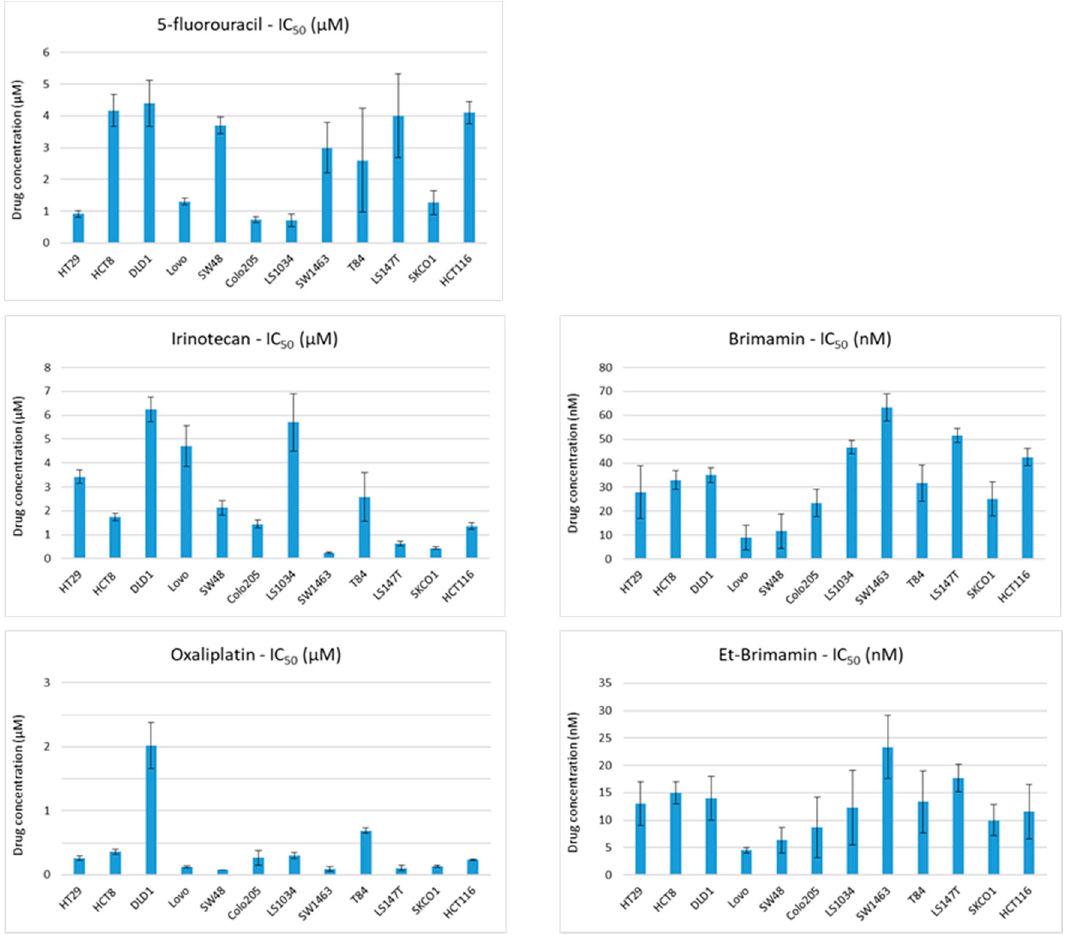
Figure 2. Cytotoxic activities of brimamin and Et-brimamin compared with those of conventional drugs in CRC cell lines. Displayed are the means of IC 50 values ± standard deviation ( n = 3).